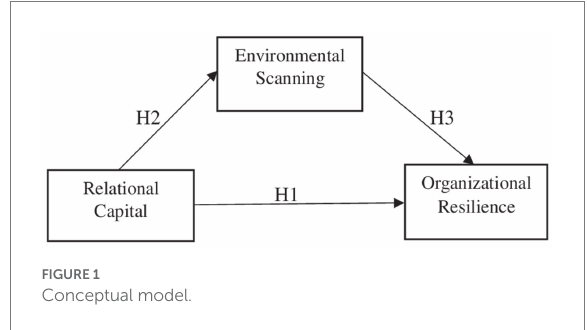
FIGURE 1 Conceptual model.